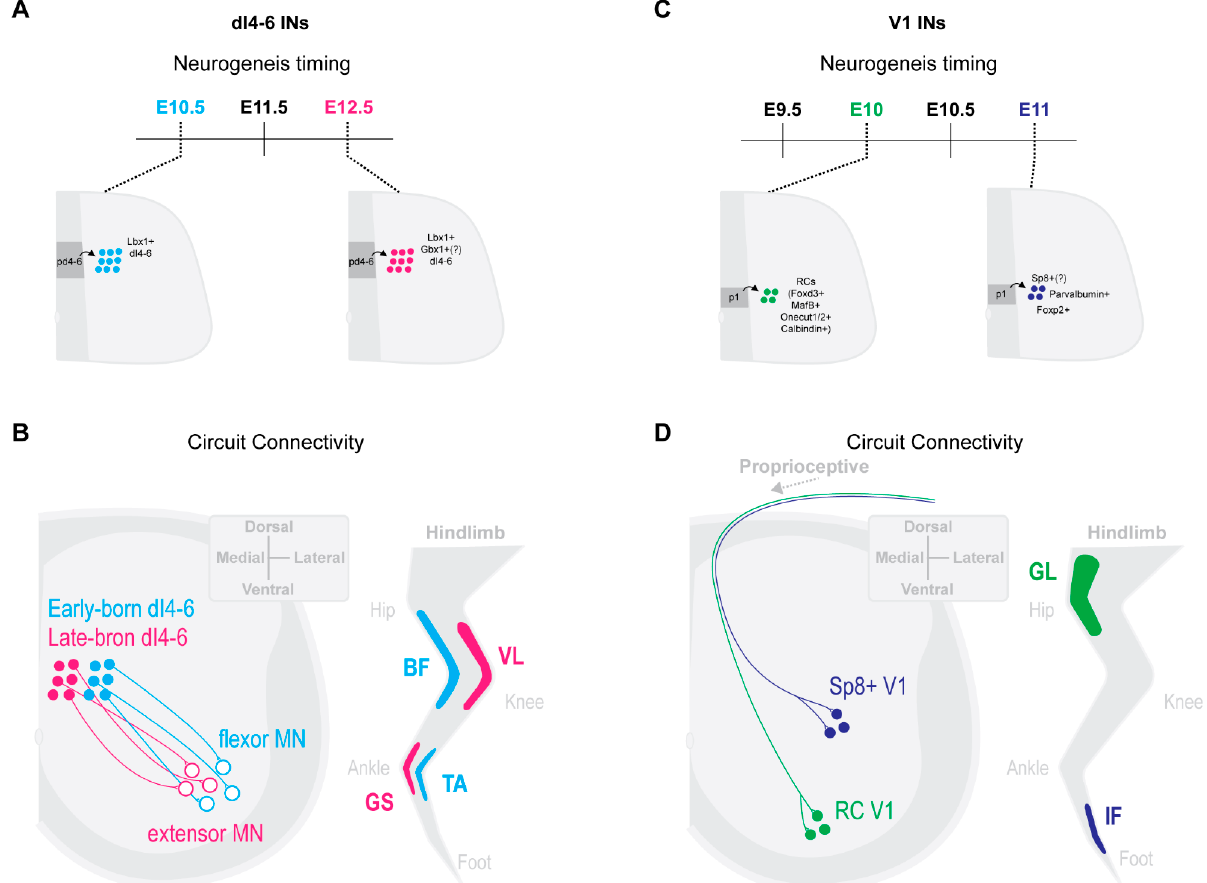
Figure 1. IN neurogenesis timing and circuit connectivity in the mouse spinal cord. ( A ) dI4-6 last-order INs emerge during either early-born (E10.5) or late-born (E12.5) neurogenesis waves [42]. Late-born dI4-6 INs are likely dILA/B IN populations and some likely express Gbx1 + [26,36,37]. ( B ) By postnatal stages, early-born dI4-6 INs are positioned preferentially laterally and innervate flexor MNs, while late-born dI4-6 INs are positioned preferentially medially and innervate extensor MNs [42] (extensor muscles, vastus lateralis (VL), gastrocnemius (GS); flexor muscles, biceps femoris (BF), Tibialis anterior (TA)). ( C ) Early-born V1 INs (E10) differentiate into Renshaw cells (RCs) [13,25], while late-born V1 INs (E11) (differentiate into Foxp2 + V1 INs [25], Parvalbumin+ V1 INs [25] and, likely, Sp8 + V1 INs [27]. ( D ) By postnatal stages, early-born RC V1 INs settle within more ventral clusters and receive more proprioceptive innervations from proximal hip muscles [6]. Presumptive later-born Sp8 + V1 INs [28] settle within more dorsal clusters and receive more proprioceptive innervations from distal foot muscles [6] (proximal muscle, Gluteus (GL); distal muscle, intrinsic foot (IF)). Likewise, neurogenetically separated V1 INs display distinct microcircuit